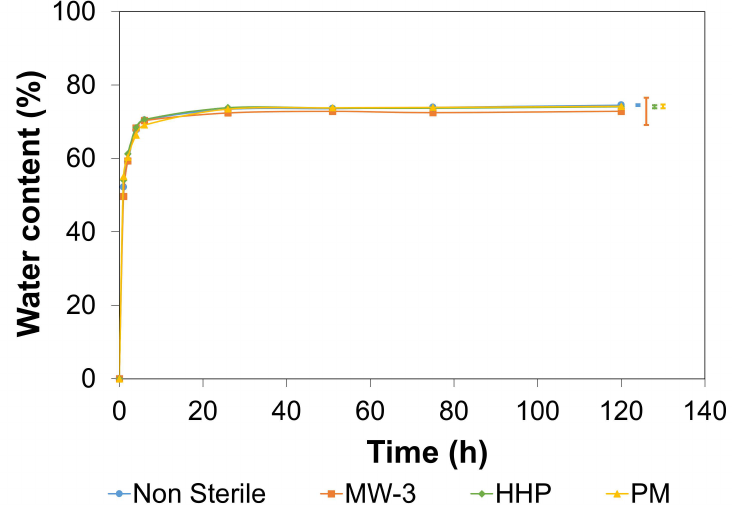
Figure 4. Water content over time for non-sterile and sterile PVA/PBO hydrogels. The error bars represent the ± mean standard deviations ( n =